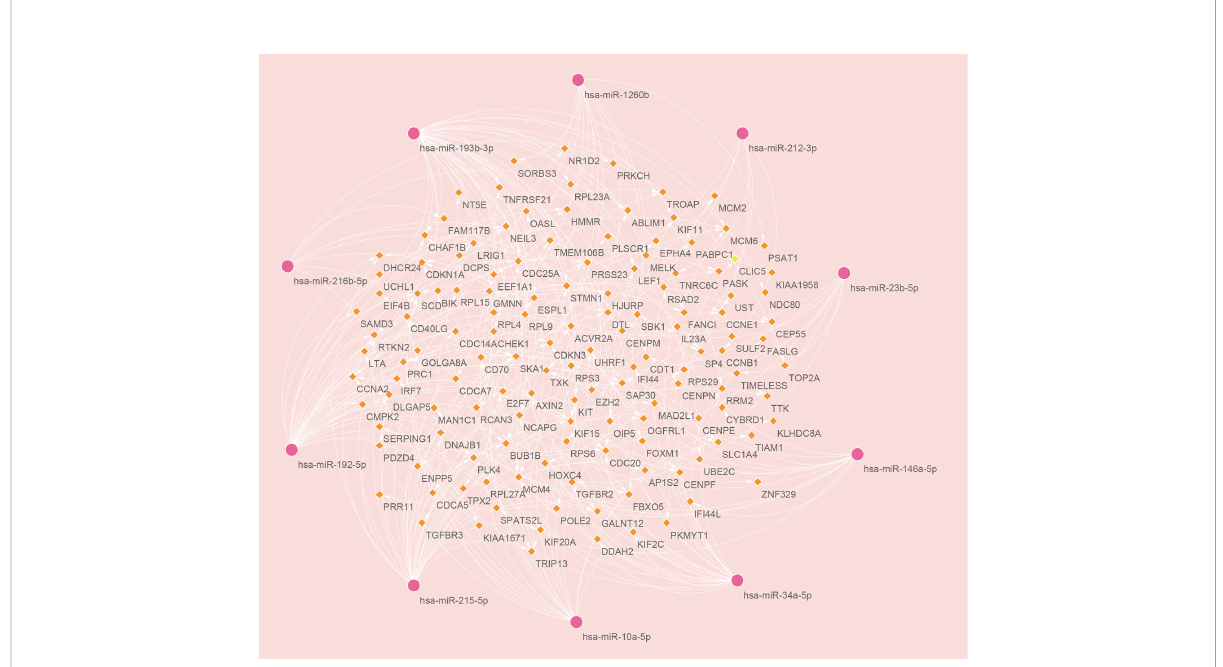
FIGURE 7 The top ten microRNAs with the top 10 lowest P values and their interactions with common differentially expressed genes. In this network, the pink circles represent miRNAs with the top 10 lowest P values, while the orange diamonds represent common differentially expressed genes correlated with miRNAs.